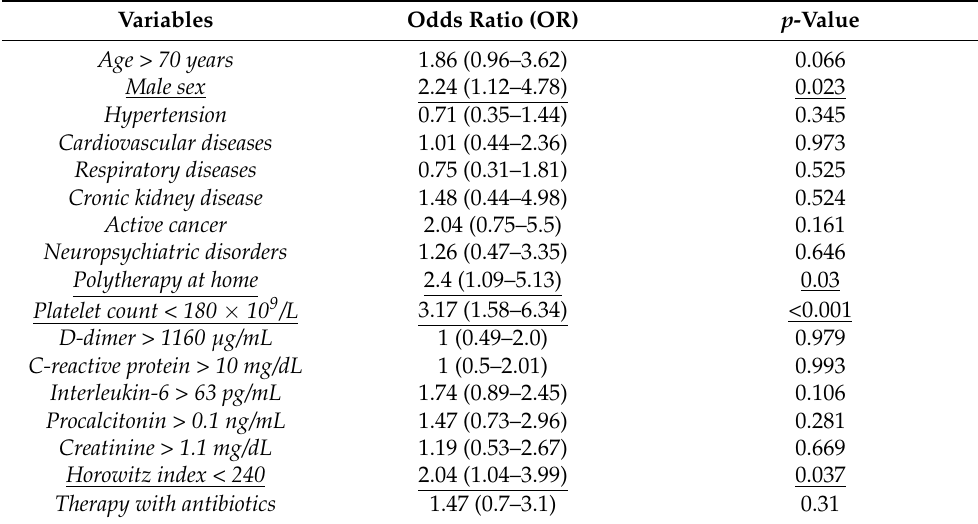
Table 4. Multivariate analysis for factors associated with hCPAP